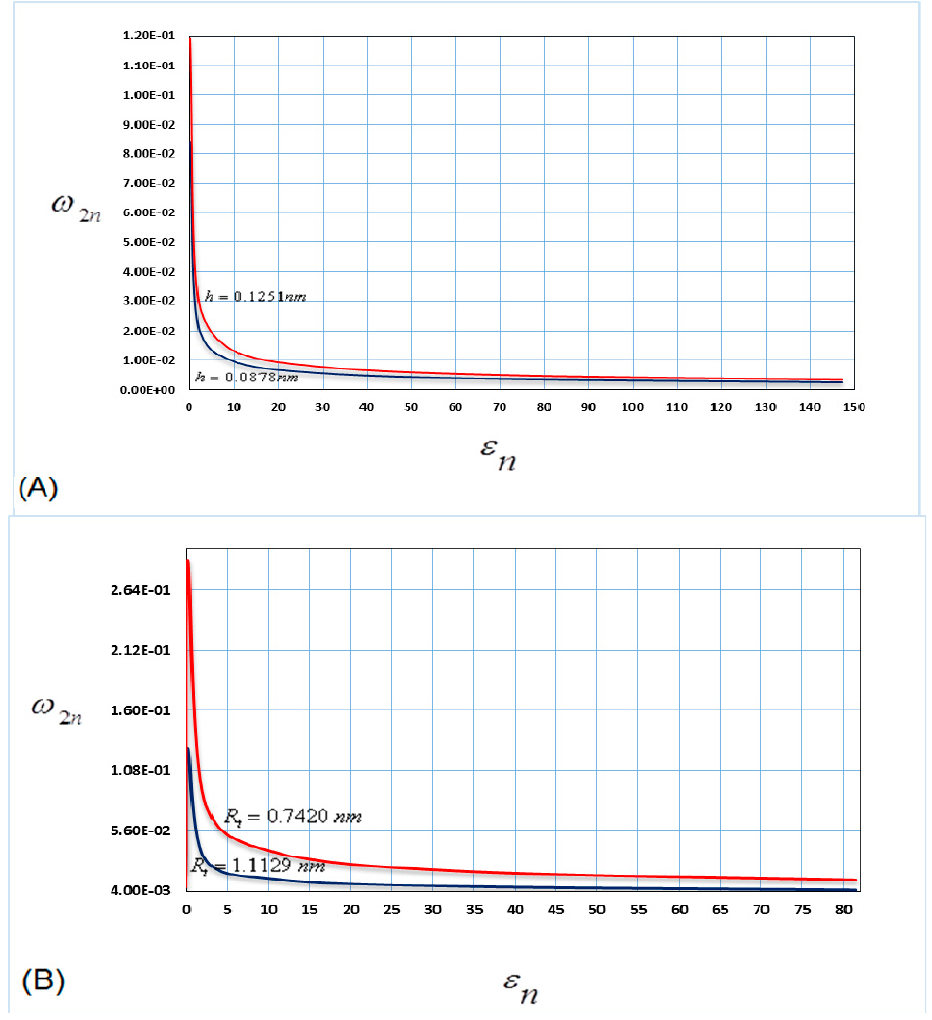
Figure 3. Nonlinear parameters versus frequency for the second mode of vibrations ( A ) h = 0.0878 nm, h = 0.1251 nm and ( B ) R t = 0.7420 nm, R t = 1.1129